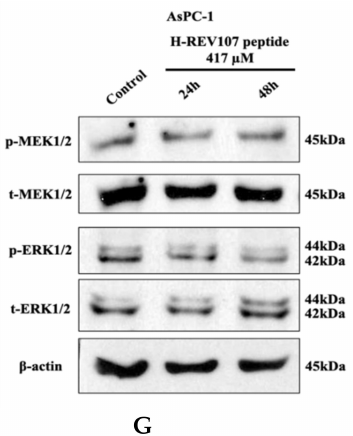
Figure 3. Cell proliferation assay and Western blot analysis. H-REV107 peptide was incubated for 72 h in five di ff erent cell lines, the ( A ) SW480, ( B ) AsPC-1, ( C ) NCI-H23, ( D ) NCI-H460, and ( E ) HCT116. Ponatinib was used for reference in five cell lines. Ponatinib to inhibit RAS-RAF-MAPK-ERK pathway was used to study cell proliferation in the KRAS mutant cancer cells for reference. The H-REV107 peptide was tested in triplicate and the data represent mean ± SD. ( F , G ) Western blot analysis of phosphorylated ( p )-MEK1 / 2, total ( t )-MEK1 / 2, p -ERK1 / 2, and t-ERK is shown in SW480 and AsPC-1 cells incubated with H-REV107 peptide for 24and 48 h. Equal loading is shown by ß-actin.